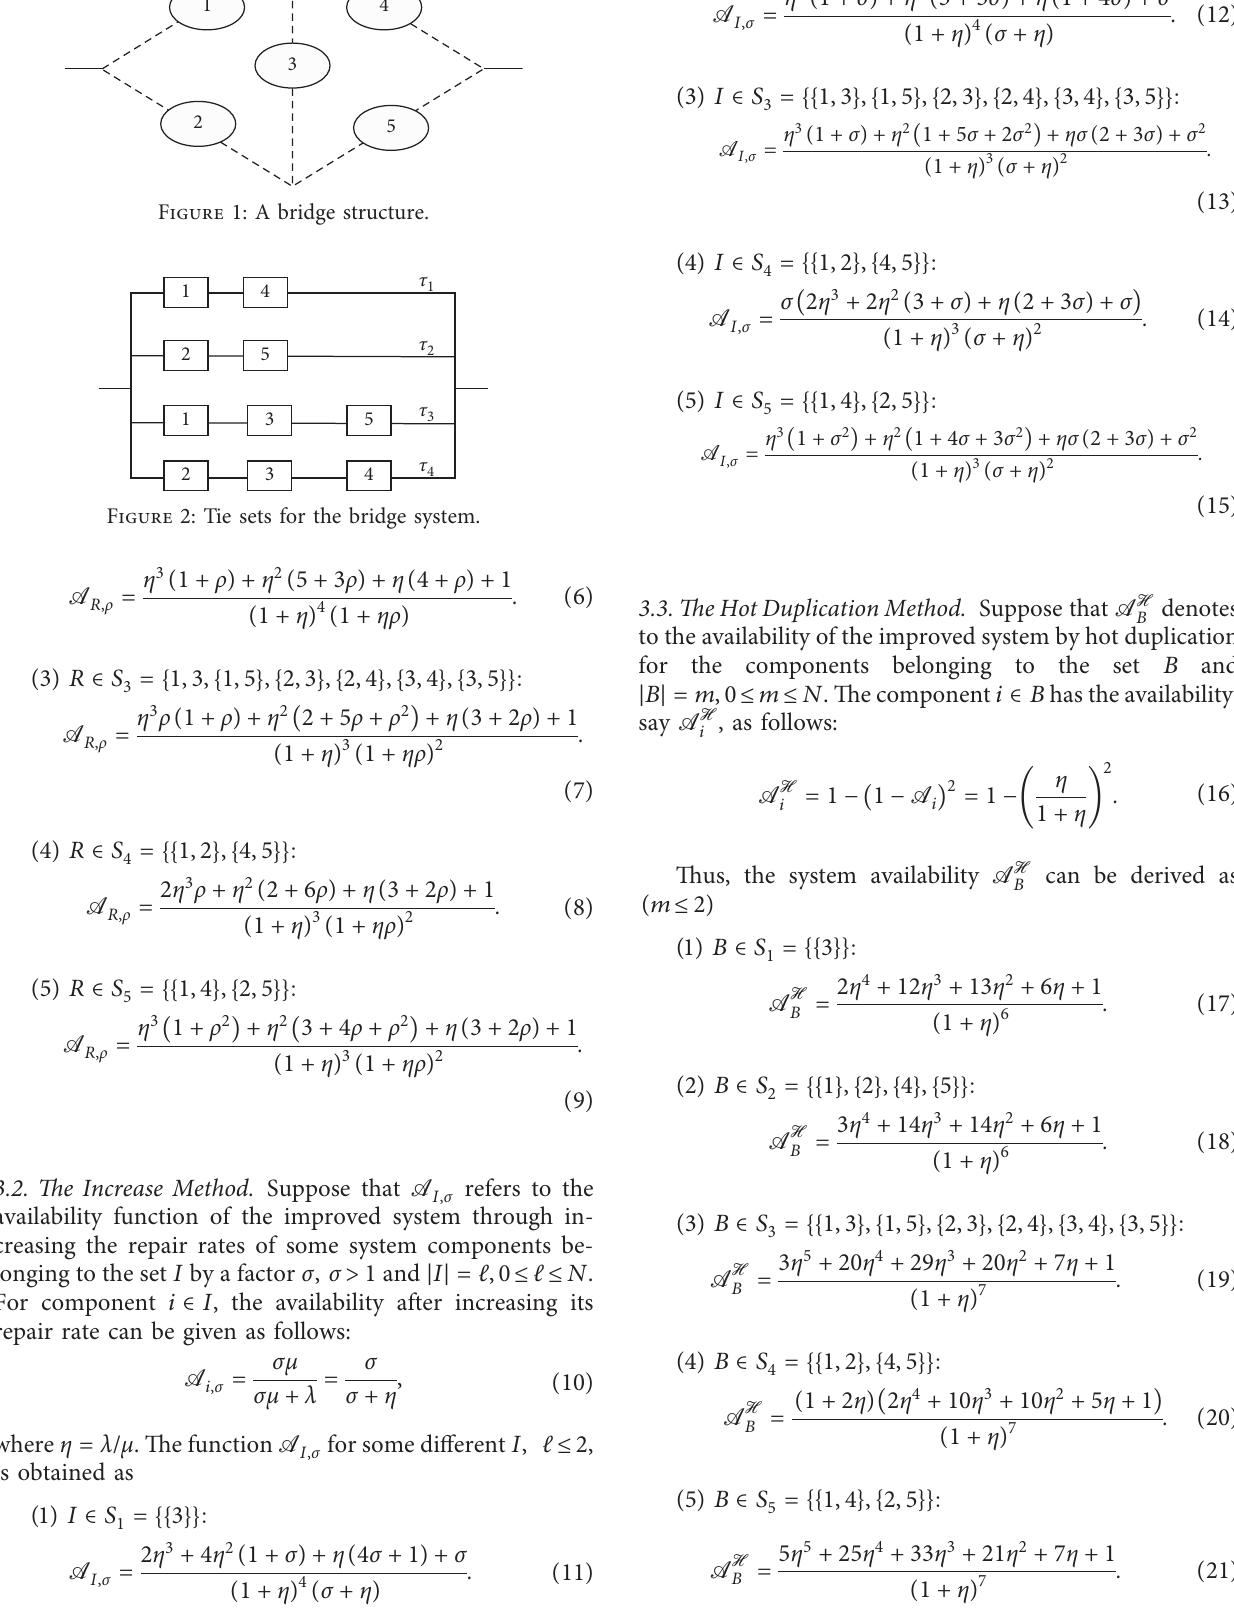
Figure 1: A bridge structure.